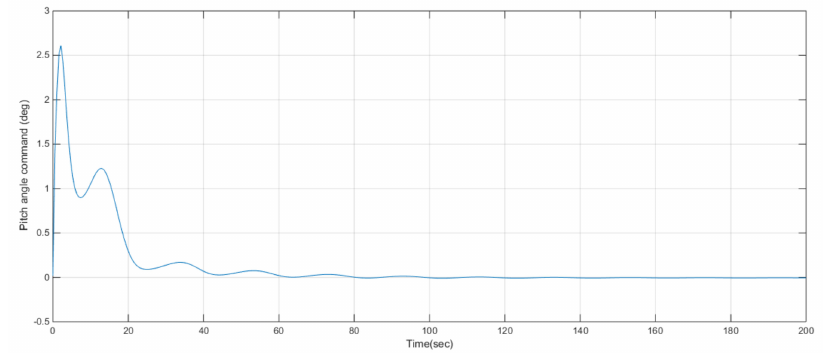
Figure 4. Pitch angle control without faults.